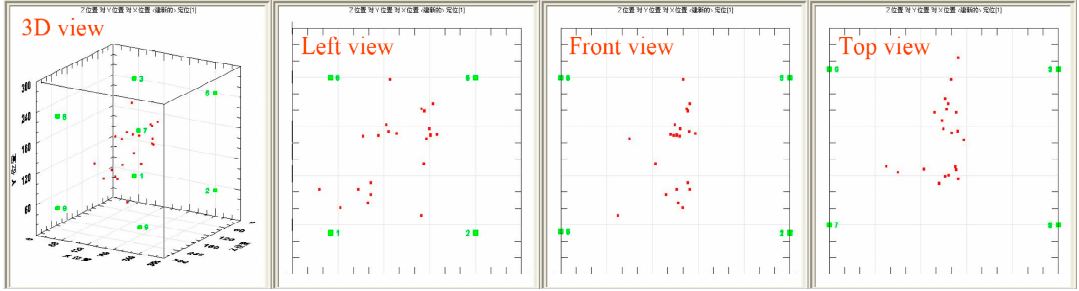
Figure 15. Spatial arrangement of acoustic emission events in the two-branched tree-type borehole hydraulic fracturing model.